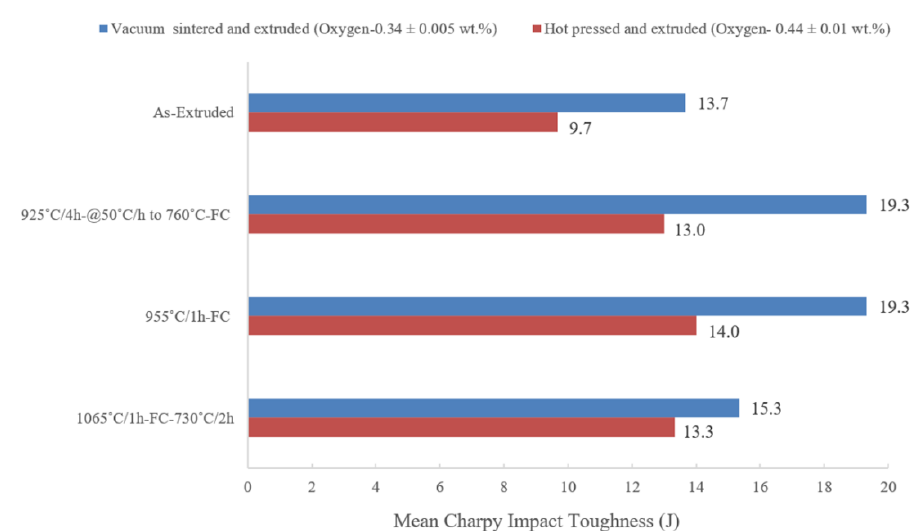
Figure 14. A comparison of mean Charpy impact toughness of heat treated Ti-6Al-4V alloy prepared via two different processing routes with different oxygen contents [23].